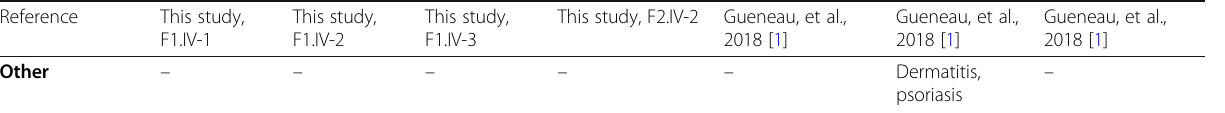
Table 2 Mutations and phenotypic features of surviving patients with KIAA1109 mutations